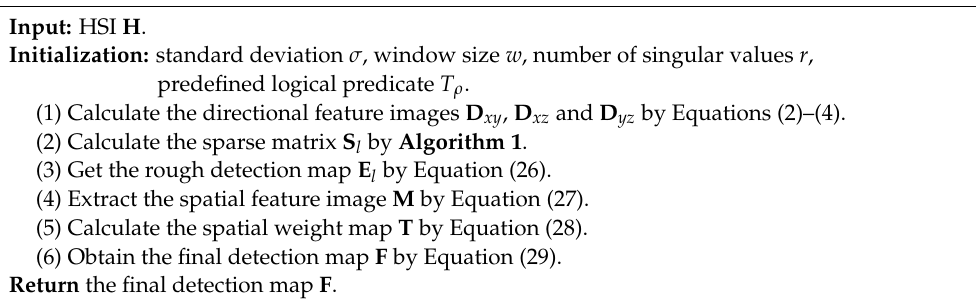
Algorithm 2 Spectral–spatial complementary decision fusion